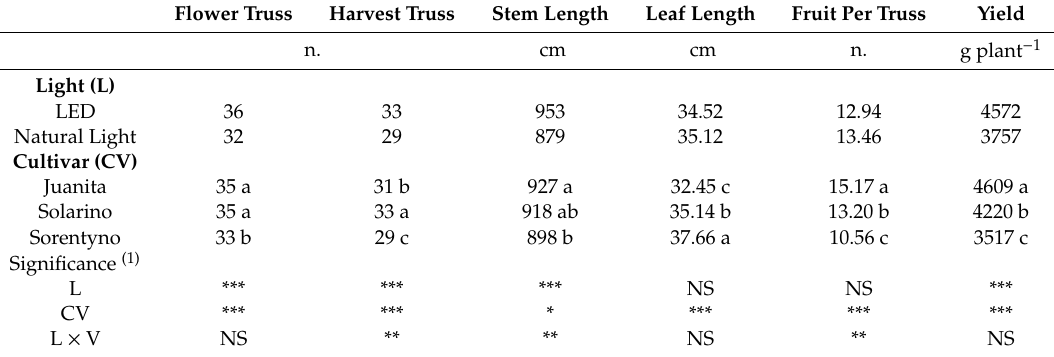
Table 1. E ff ects of supplemental light (SL) treatment (LEDs) and cultivar on flower truss, harvest truss, stem length, stem diameter, leaf length, fruit per truss and yield of tomato plants. LEDs were switched on from 122 to 243 days after transplanting (DAT). Values in the table are the average of measurements taken during the growing cycle.